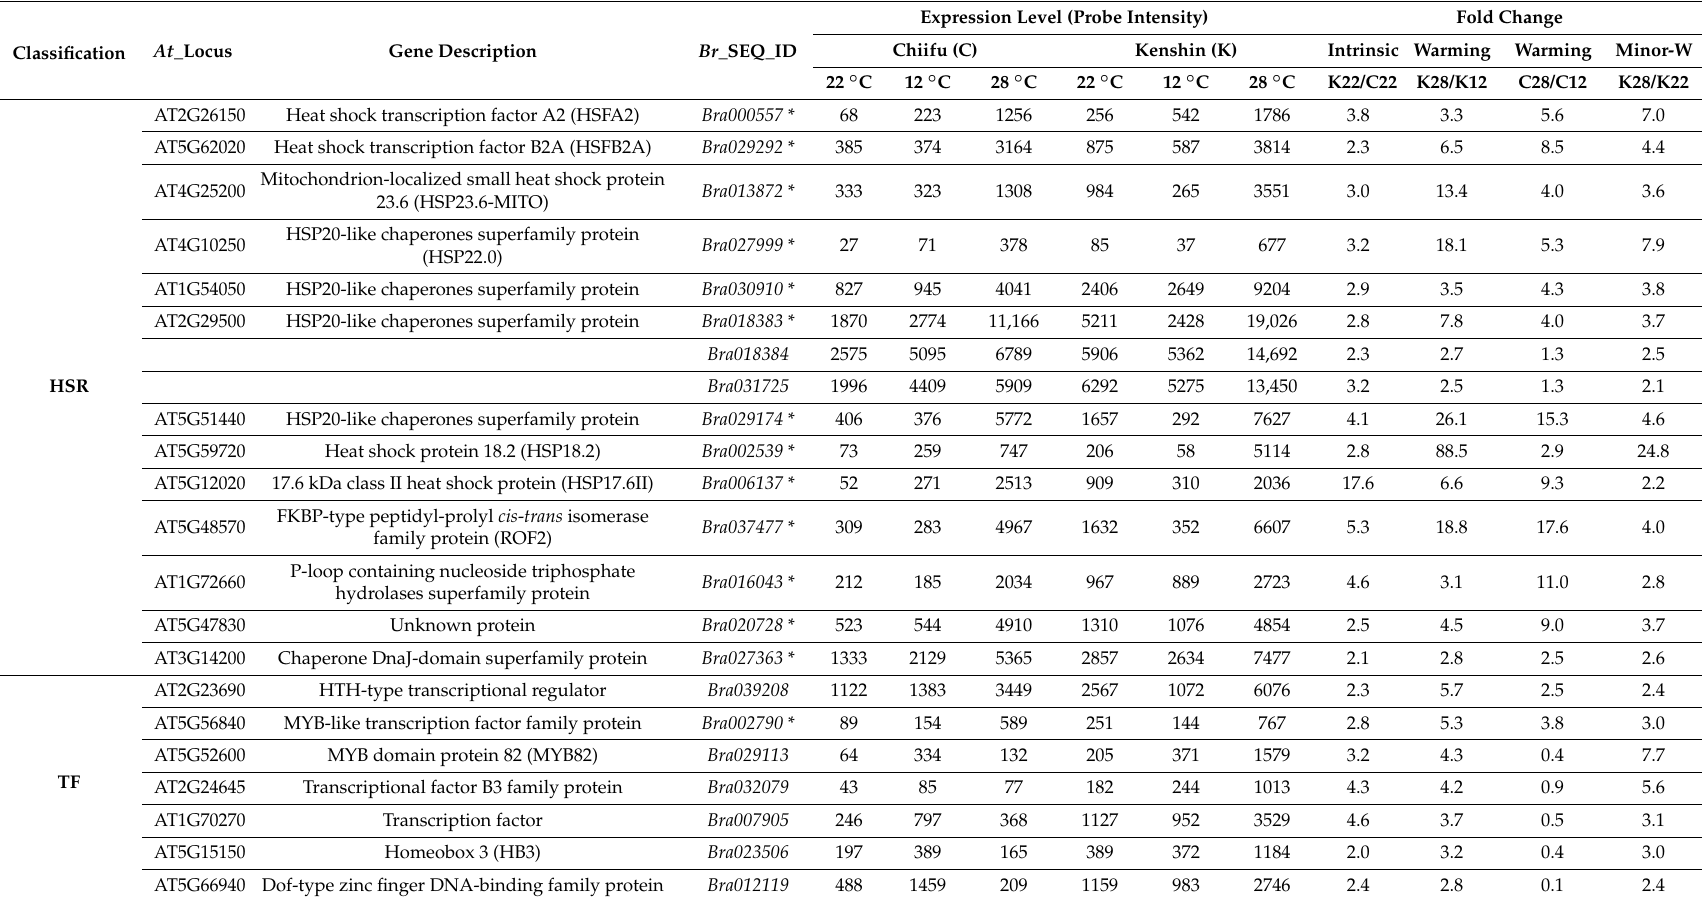
Table 3. Genes associated with the adaptation of Kenshin to HT based on microarray analysis. The selection criteria were (1) intrinsic levels of expression in Kenshin at 22 ◦ C over 2-fold higher than those in Chiifu; and (2) expression levels under both warming and minor-warming conditions at least 2-fold higher in Kenshin than in Chiifu. HSR, heat shock response; TF, transcription factor; SF, splicing